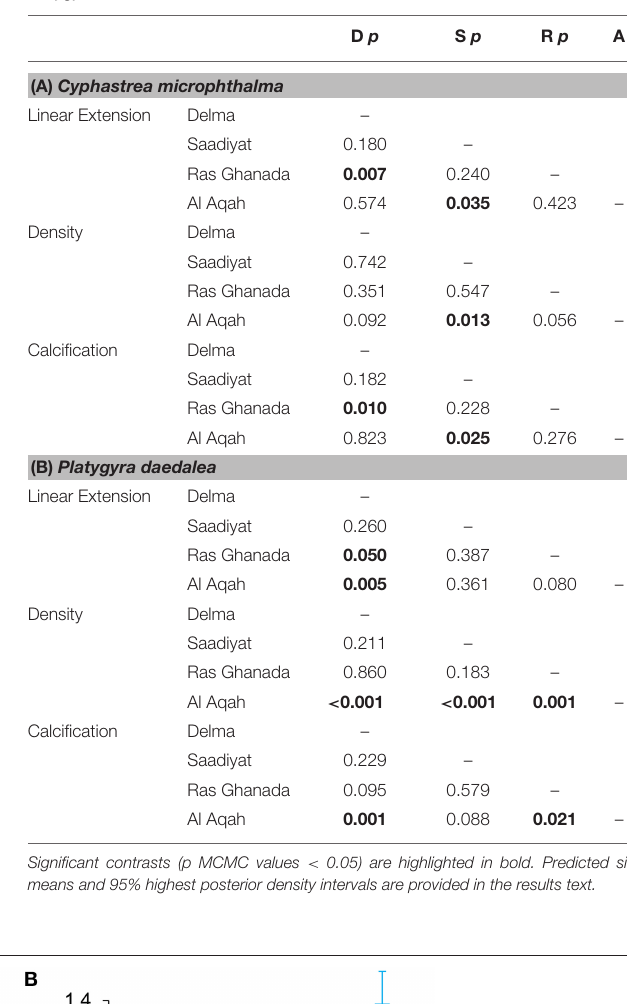
Frontiers in Marine Science |